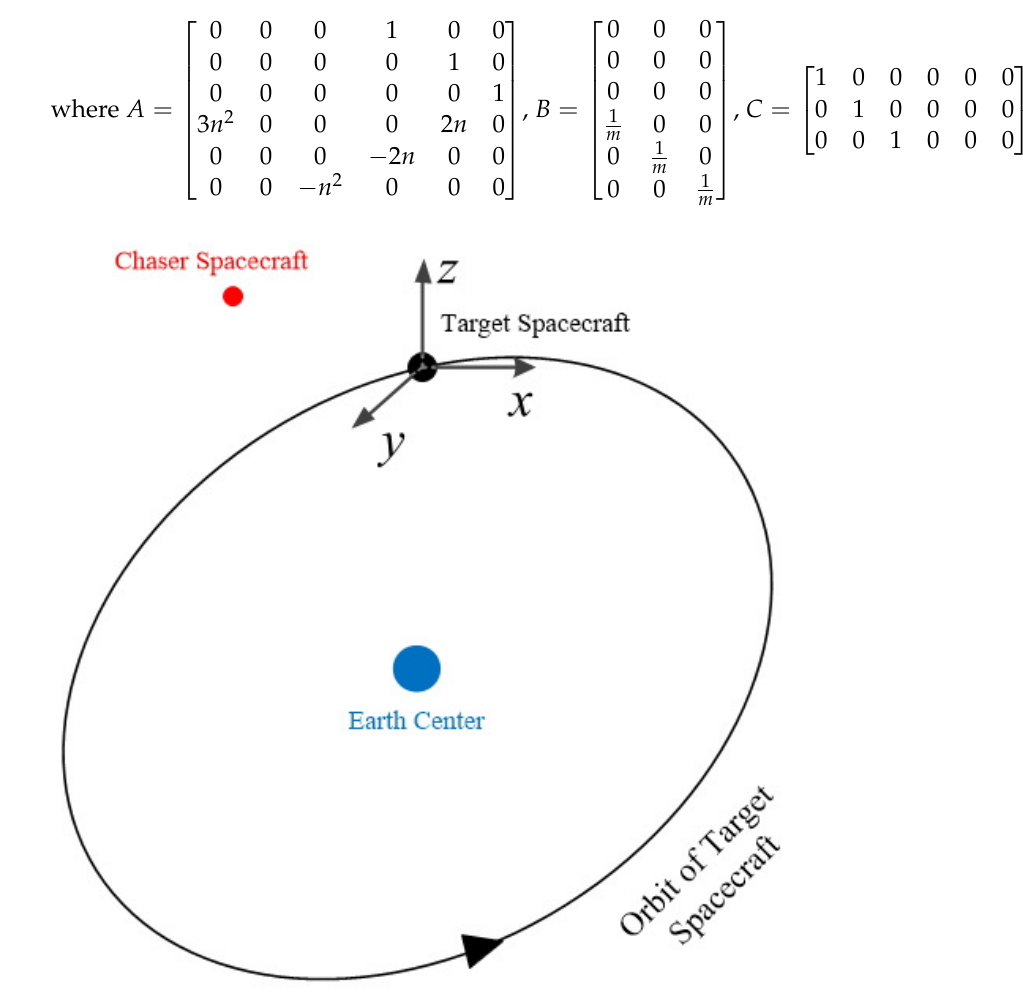
Figure 1. Coordinate